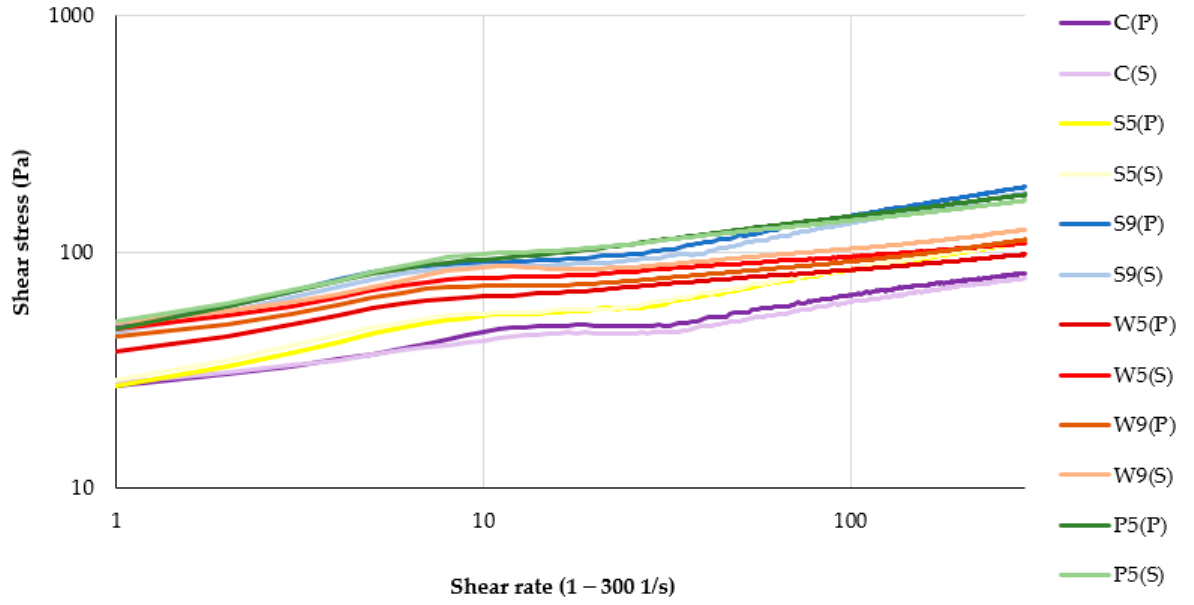
Figure 4. Apparent viscosity of plant-based pur é e samples enriched with various proteins. The initial letters in sample abbreviations, C—control (without protein additive), S—soy, W—whey or P—pea protein, represent the samples used in the formulations; the numbers represent the proportions of protein added (5 or 9 g/100 g); the letters in brackets represent the type of secondary treatment (P—pasteurization; S—sterilization). Horizontal lines indicate the target values. Different letters indicate significant differences between samples ( p ≤ 0.05).